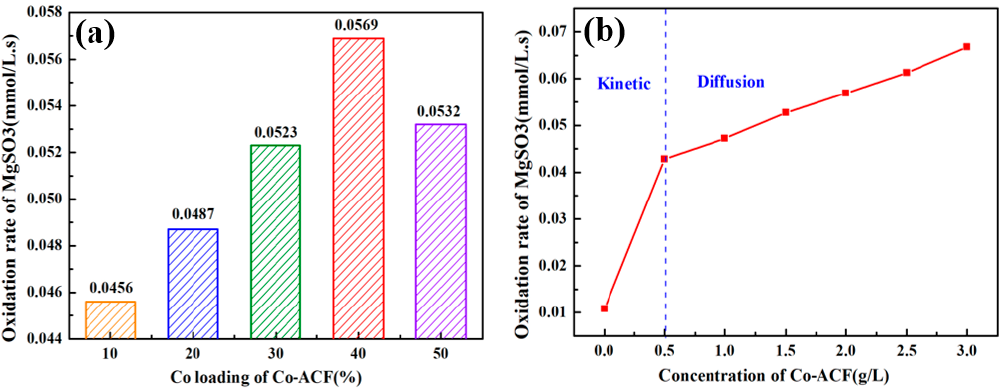
Figure 4. ( a ) E ff ect of impregnated Co on oxidation rate of MgSO 3 ; ( b ) E ff ect of catalyst concentration Figure 4. ( a ) Effect of impregnated Co on oxidation rate of MgSO 3 ; ( b ) Effect of catalyst concentration on the oxidation rate of MgSO 3 (Co wt % = on the oxidation rate of MgSO 3 (Co wt % = 40%).